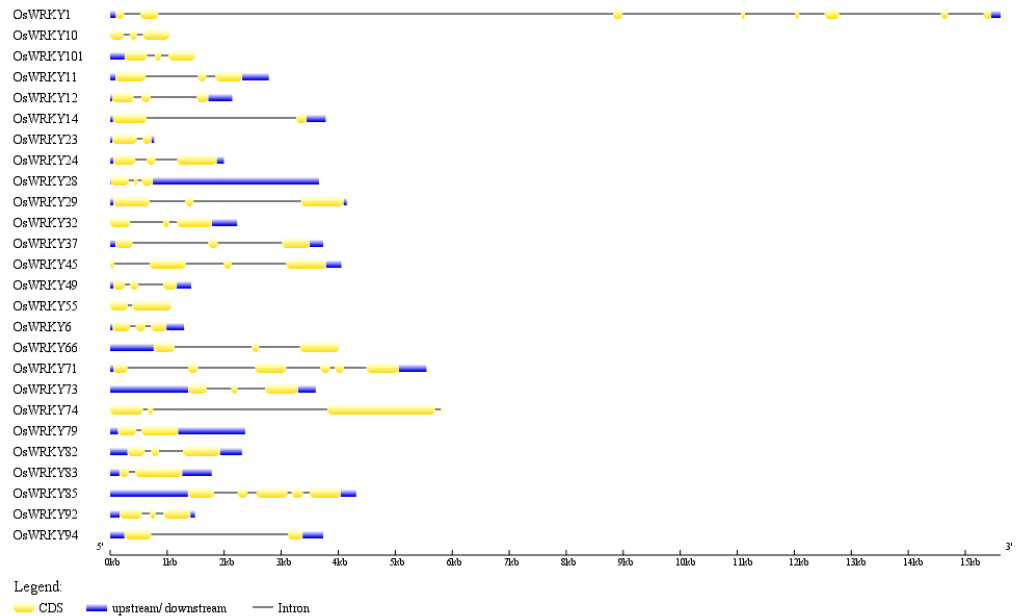
Figure 5. Structural organization of OsWRKY TF genes. Introns, exons, and untranslated regions (UTR) are represented by black lines, yellow, and blue rectangles. The scale bar denotes the size of the gene.